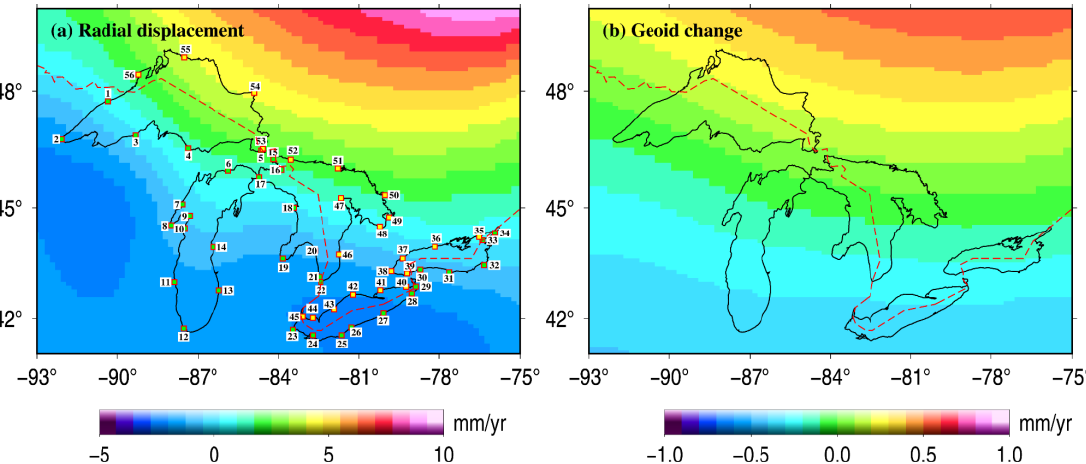
Figure 4. Rates of ( a ) radial displacement and ( b ) geoid change due to GIA in the Great Lakes region. The water level stations used in this study are numbered in ( a ). The red line in ( b ) represents the border between USA and Canada. Table 1. Rates of radial displacement and geoid change in the Great Lakes.